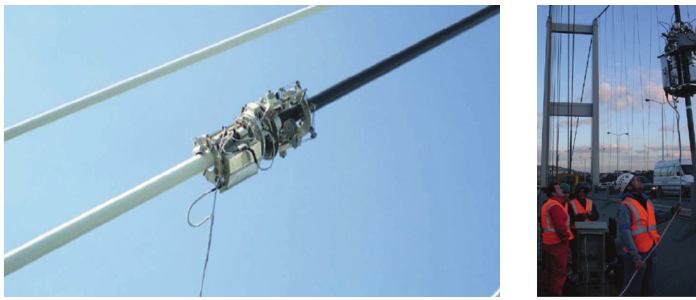
Figure 10: Pole and pipe inspection robots.